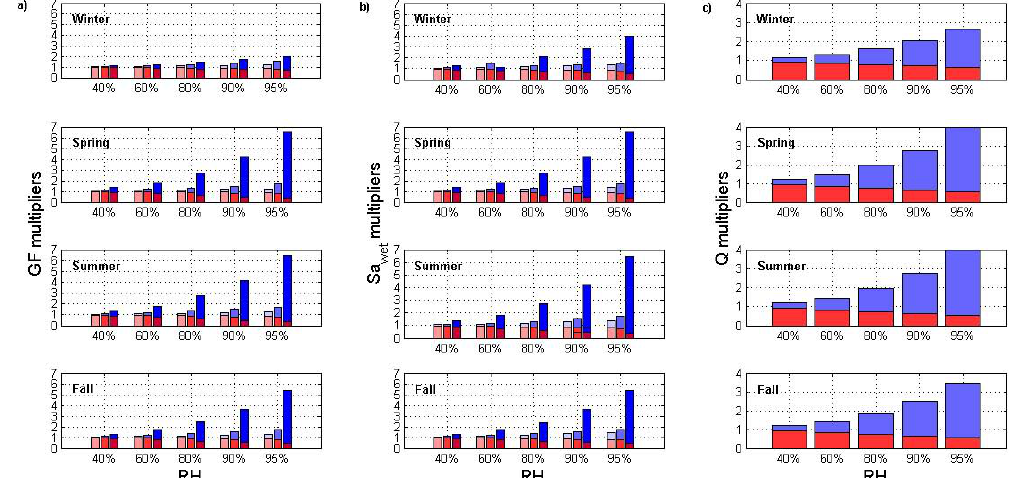
Fig. 11. Sensitivity analysis for (a) the growth factor (GF) estimation, (b) the wet aerosol ion sink ( Sa wet ) and (c) the ionization rate (Q) when the parameterized γ values are increased by a factor of 2 (blue) or decreased by a factor of 2 (red). Multipliers are given as a function of relative humidity (a, b, c) and particle size (a, b) . For (a) and (b) the lightest bars represent the multipliers for the smallest particle diameter (10nm), the medium bars represent the mean multipliers for the size range 100–300nm and the darkest bars represent the multipliers for the largest particles